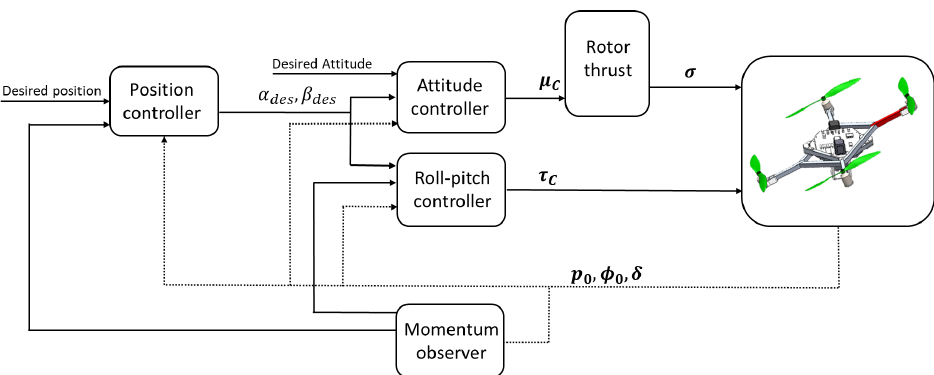
Figure 2. Block scheme of the overall control architecture, including the two loop controller, the interaction force estimator, and the propeller’s thrust